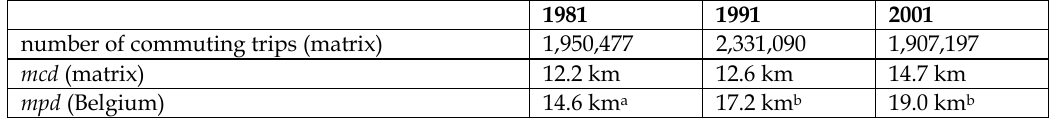
Table 1. Observed commuting trips and commuting